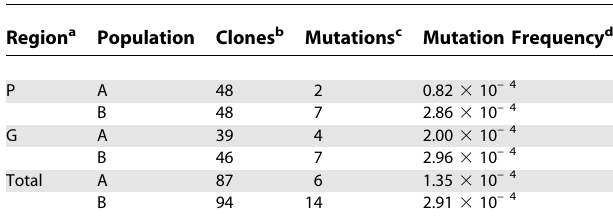
Table 1. Genetic Variability of VSV Populations A and B